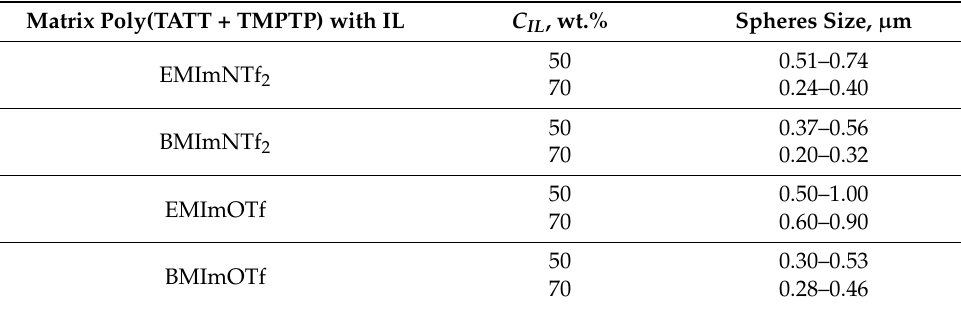
Figure 4. SEM micrograph of ionogel matrix obtained in presence of 50 wt.% of EMImNTf 2 . Table 2. Size of polymer spheres in synthesized